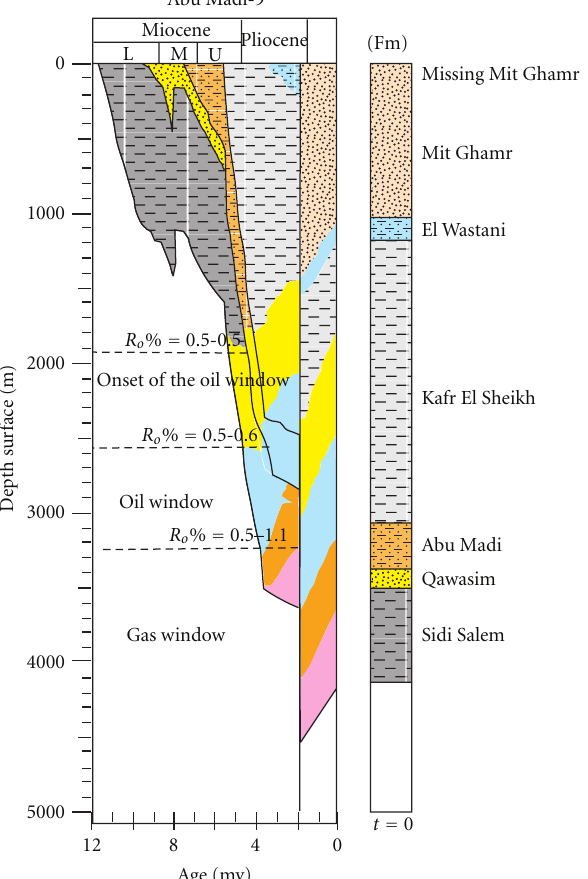
Figure 11: Burial history curve with hydrocarbon zones for the Abu Madi and Sidi Salem formations.